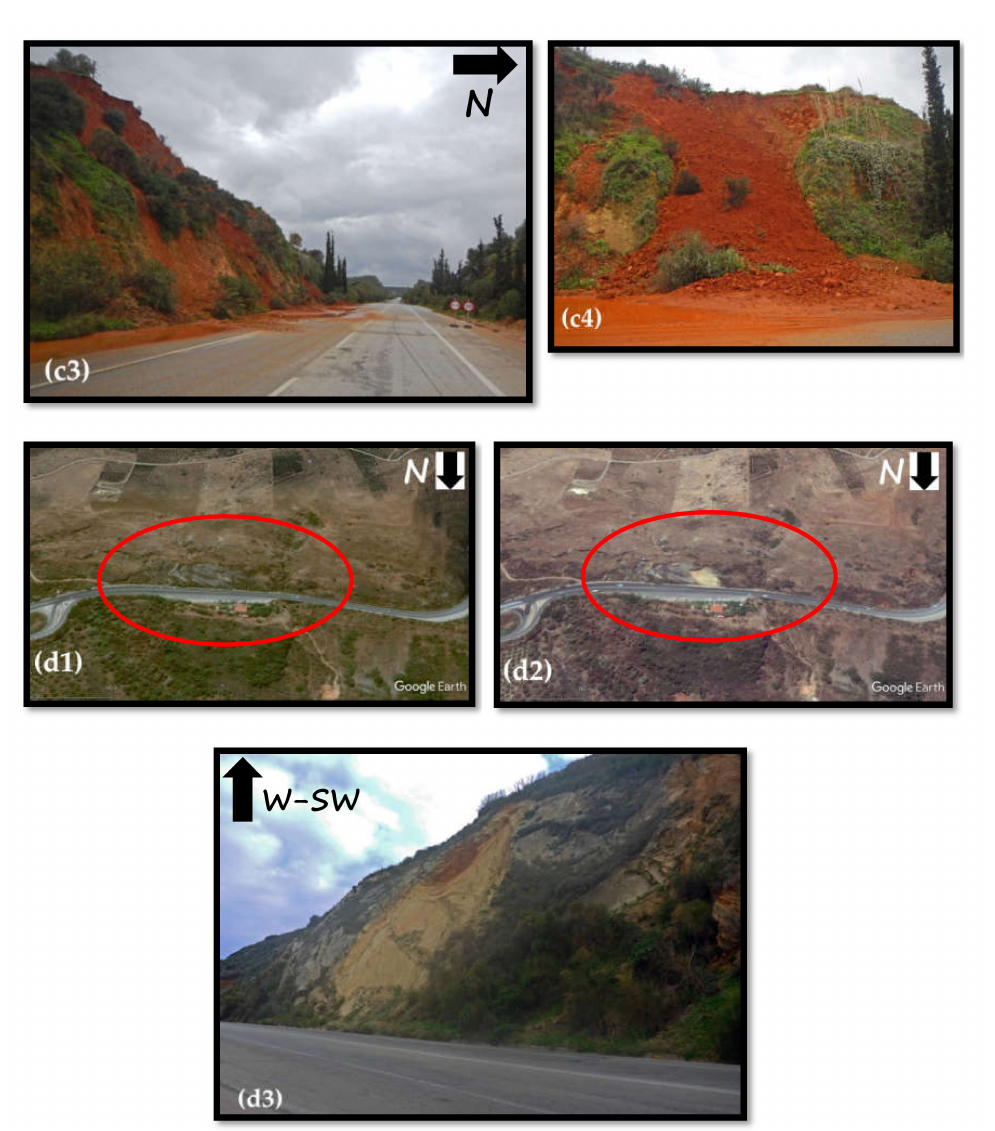
Figure 4. ( a ) The spatial distribution of three landslide events occurred recently along the motorway A90 due mainly to intense rainfalls, ( b1 – b2 ) Google Earth images showing the pre and post landslide event of Stalos area, ( b3 – b4 ) field survey photos of Stalos landslide event, ( c1 – c2 ) Google Earth images showing the pre and post landslide event of Galatas area, ( c3 – c4 ) field survey photos of Galatas landslide event, ( d1 – d2 ) Google Earth images showing the pre and post landslide event of Kalami area, ( d3 ) field survey photos of Kalami landslide